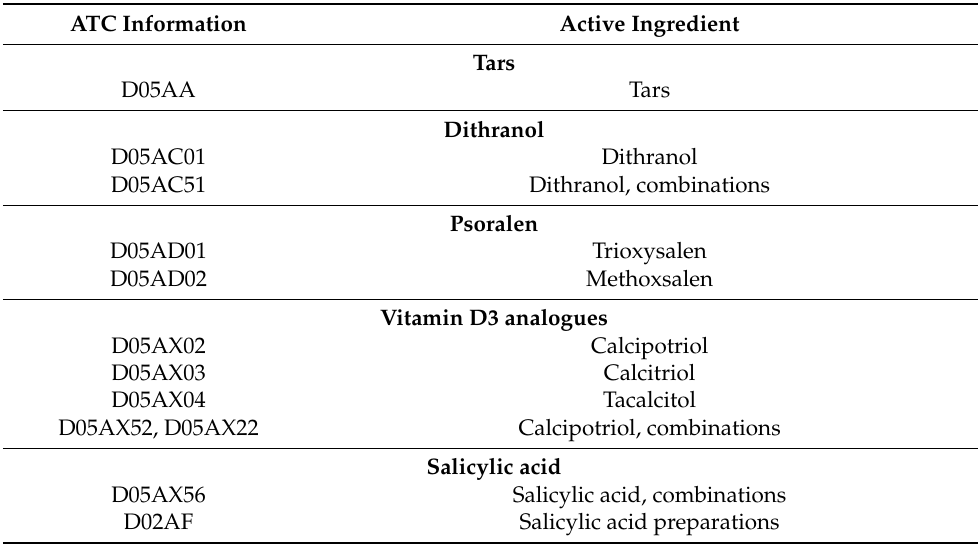
Table 4. Topical therapies according to ATC codes